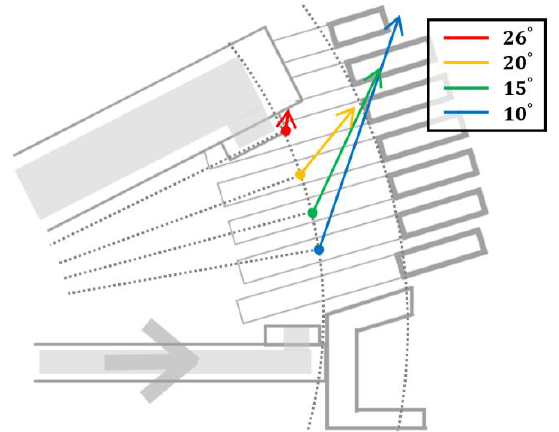
Figure 10. Vector of synthetic force according to the angle between contacts.